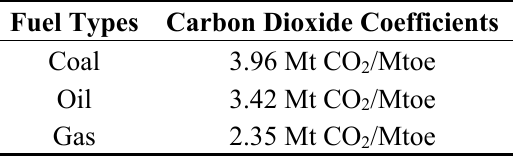
Table 11. Carbon dioxide emission coefficients for fossil